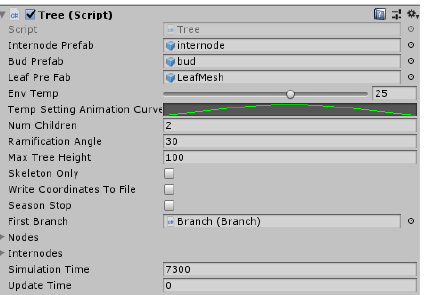
Figure 4. The species-specific parameters (number of children, ramification angle, max tree height) modifiable via Unity© inspector panel. The “simulation time” parameter sets the temporal length of the simulation (1 s = 1